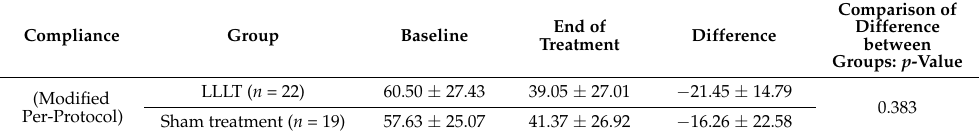
Table 5. Treatment effects (RQLQ, mPP set).